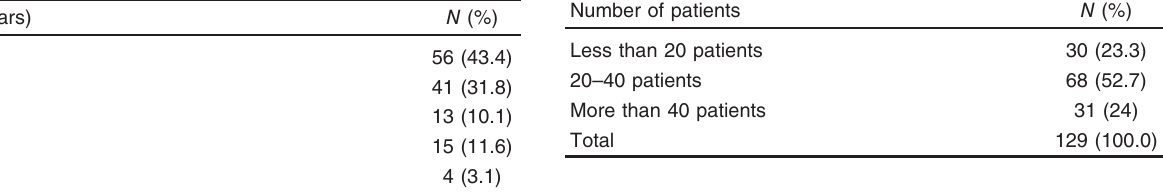
Table 6 Description of doctors according to the number of new chronic obstructive pulmonary disease patients diagnosed per